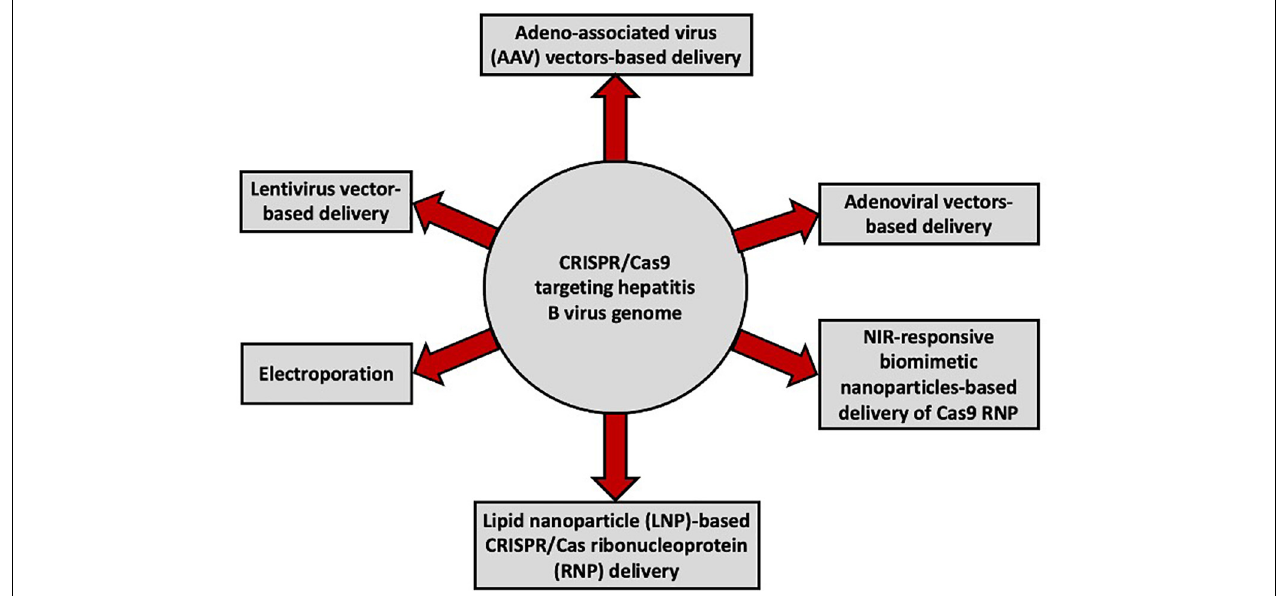
FIGURE 2 | Vectors used for the delivery of CRISPR/Cas9 targeting the HBV genome in different in vitro and in vivo